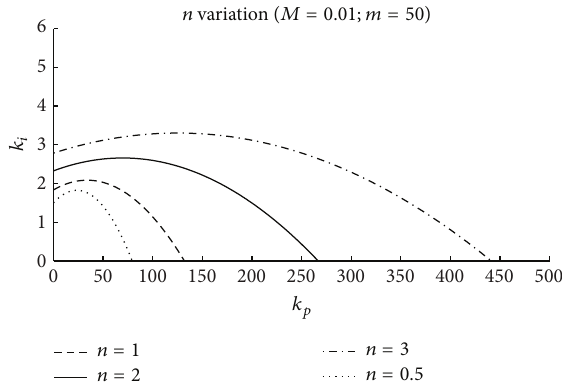
Figure 5: Stability regions: effect of thesurface area of thesurge tank ( 𝑛